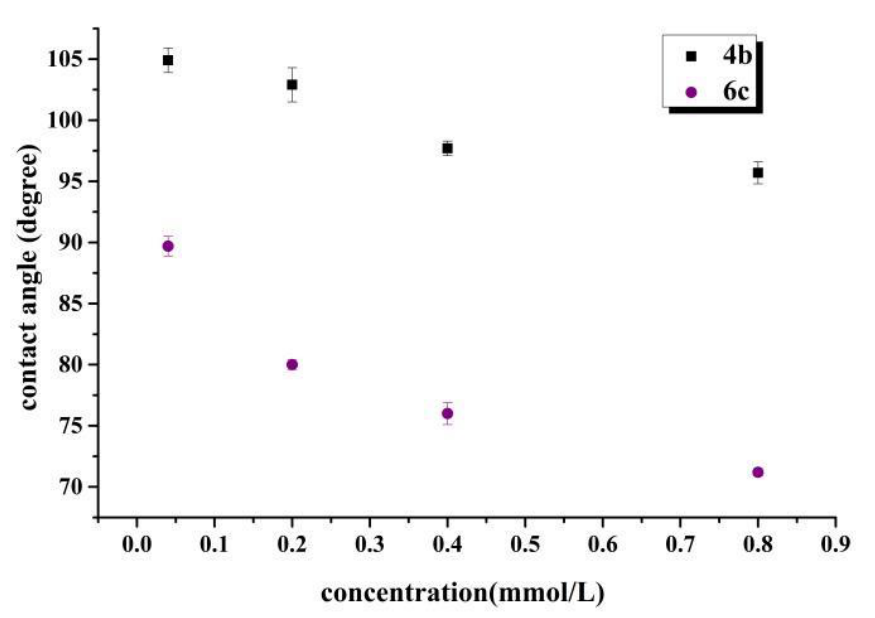
Figure 10. Contact angles of 4b and 6c at various concentrations.